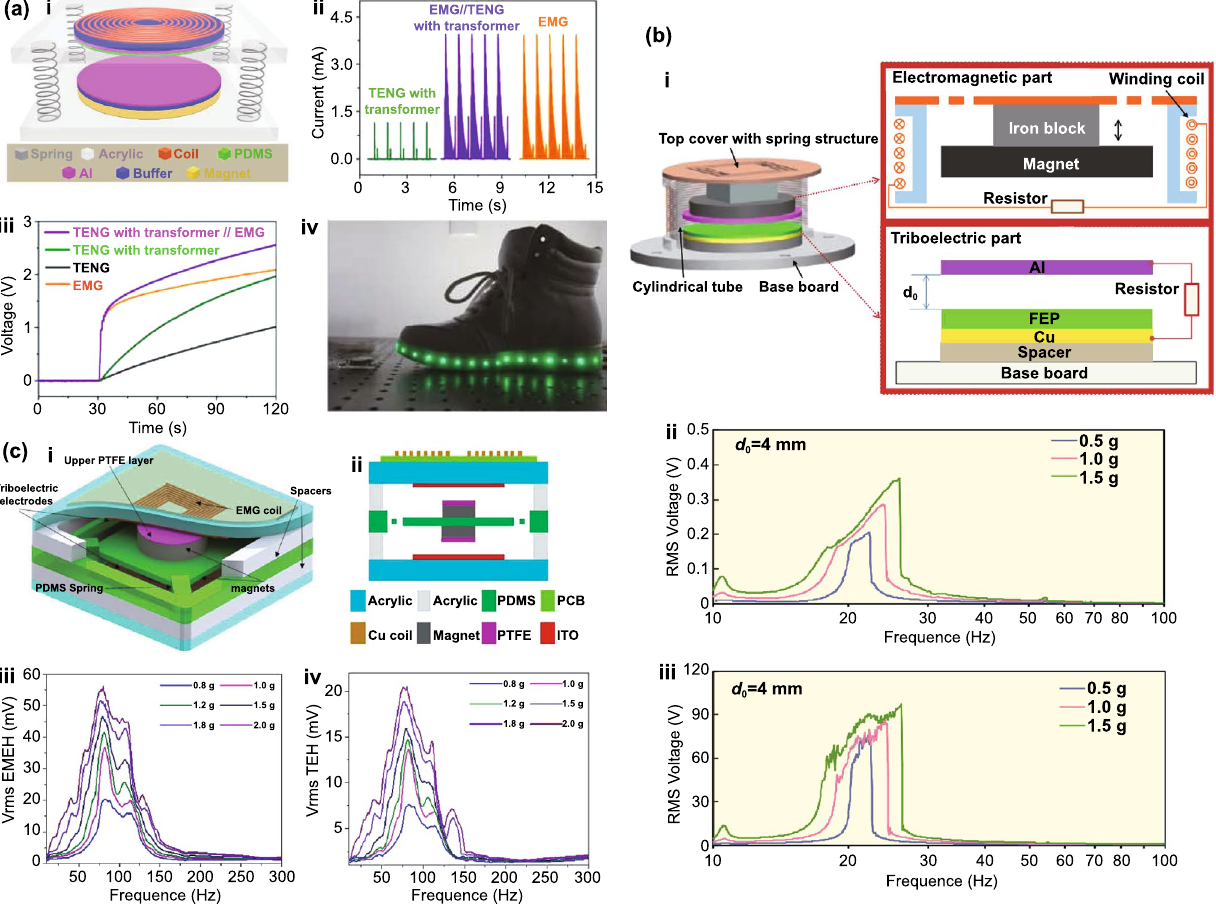
Fig. 20 a (i) Schematic diagram of the hybridized nanogenerator designed by Zhang et al. (ii) SC current measured from the TENG with trans- former, EMG and TENG with transformer connected in parallel with the EMG. (iii) Measured voltage across a 47 μF capacitor charged by the TENG, EMG and hybrid device (TENG with transformer in parallel with the EMG) (iv) Photograph of the hybridized generator acting as power source for on-shoe LEDs. Reproduced with permission from Ref. [89]. Copyright 2015, American Chemical Society. b (i) Schematic diagram of the spring hybrid generator developed by Liu et al. and cross section views of the EMG and TENG parts . Frequency response of the OC RMS voltage for an initial gap distance of 4 mm and for different amplitudes of acceleration of the (ii) EMG and (iii) TENG. Adapted from Ref. [90]. c (i) Schematic drawing of the multimodal broadband hybrid energy harvester designed by Gupta et al. (ii) Cross sectional view of the device. Frequency RMS OC voltage spectrum for the (iii) EMG and (iv) TENG at accelerations from 0.8 g to 2 g. Reproduced with permission